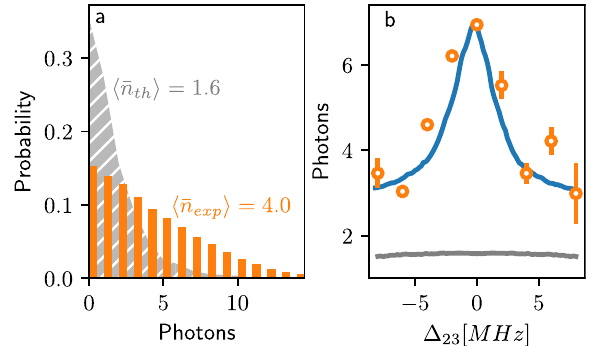
Fig. 3 Photon generation from a dark state. a The photon-number probability distribution (orange) measured for zero detuning ( Δ 23 = Δ 12 = 0) and a 60 μ s long observation interval. As a comparison, a quantum simulation was performed to fi nd the expected photon-number distribution (gray curve in background) from a free-space atom interacting with the same driving fi elds. n means the average photon number. b The experimentally measured number of photons (orange), extrapolated to in fi nite measurement time as a function of Δ 23 . The curve (blue) is the number of photons from the quantum Monte-Carlo simulation of the experiment. It serves for qualitative comparison, is scaled in the vertical direction, and an offset is added to compensate for experimental imperfections. The gray curve shows the full quantum Monte-Carlo simulation for a free-space atom. The error bars in b represent one standard deviation and are too small to be visible for some of the data points.